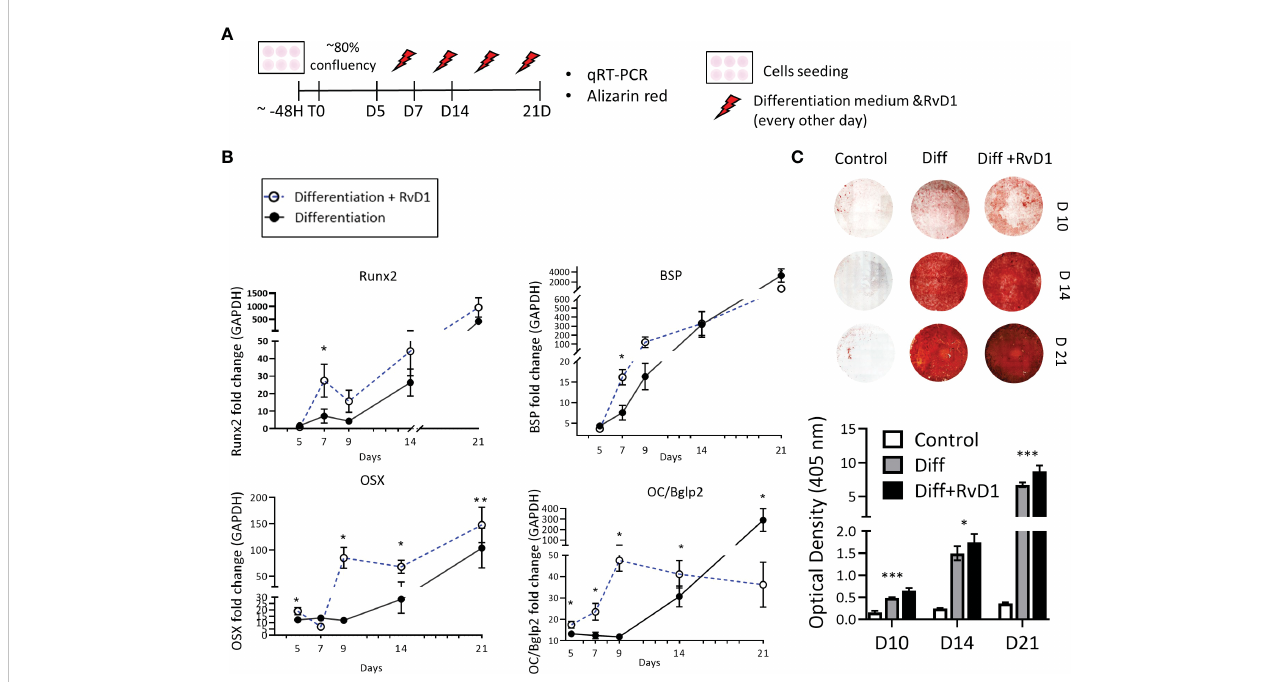
FIGURE 5 Resolvin D1 increased osteoblasts differentiation and calcium deposition. (A) Experimental timeline: MC3T3E-1 pre- osteoblasts cells were plated and treated with differentiation supplemented medium (materials& methods) with and without RvD1 (200 nM) for 21 days. Undifferentiated cells were analyzed as a control group. (B) RNA was extracted from cells in time points: days 5, 7, 9, 14, 21 and mRNA expression was detected by qRT-PCR. Runx2, OSX, BSP and OC/BGKAP2mRNA expression normalized to undifferentiated cells control group. (C) In 10, 14 and 21 days, cells were blocked in paraformaldehyde 4% and stained for Alizarin red staining (above), and numerical evaluation for Alizarin red optical density in 45 nm was calculated (graph below) (days 10, 14 21, N=5-6/group). The asterisk symbol represents a statistical signi fi cance *<0.05; **< 0.01; ***<